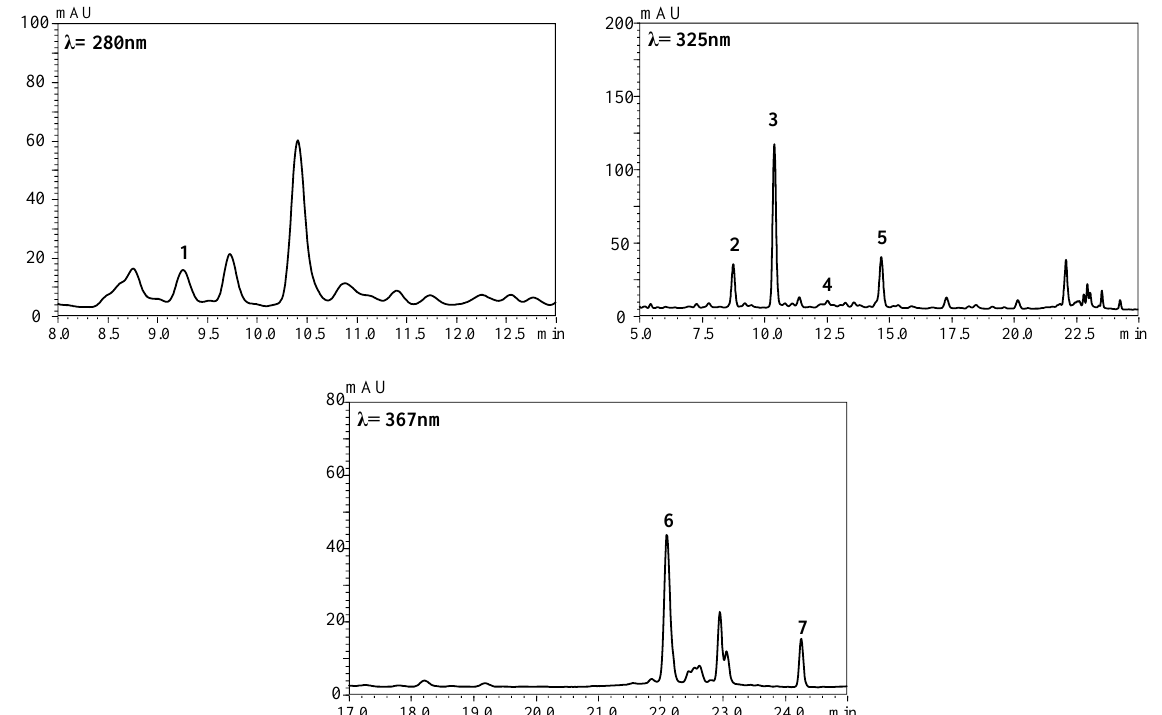
Figure 2. HPLC-DAD chromatograms of the phenolic compounds of the honey mixed beverage. The compounds identified were catechin (1), 4-caffeoylquinic acid (2), 5-caffeoylquinic acid (3), p -coumaroylquinic acid isomer 1 (4), p -coumaroylquinic acid isomer 2 (5), quercetin-3- O -glucoside (6), and quercetin (7).